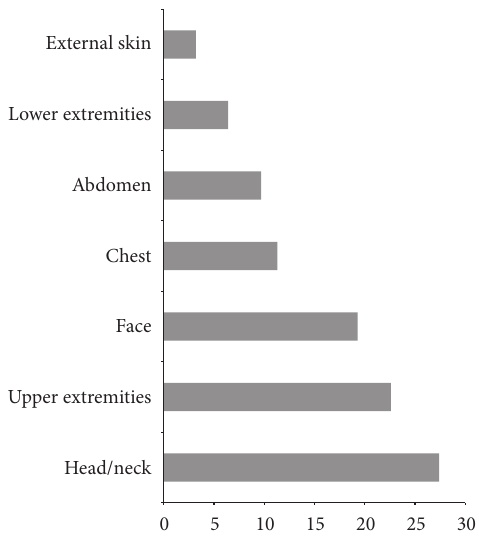
Figure 1: Percentage of injured regions among E-cyclists (%).